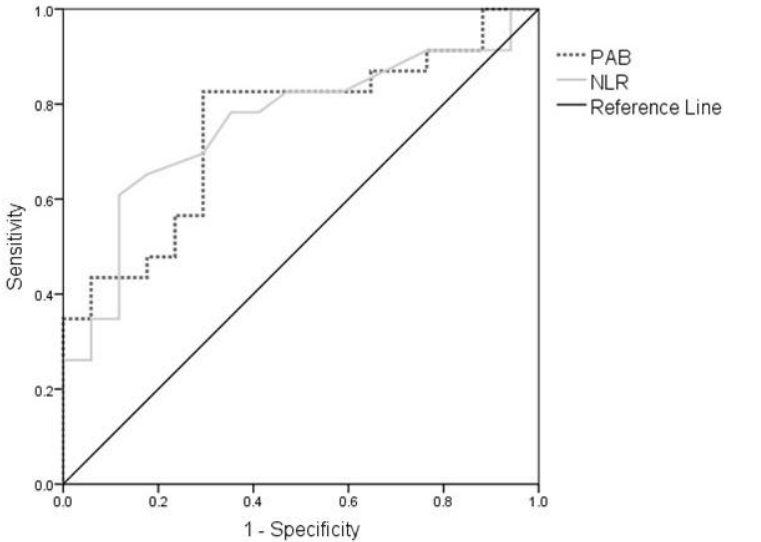
Figure 2. ROC curve for PAB and NLR. Abbreviations: ROC, Receiver operating characteristic curve;